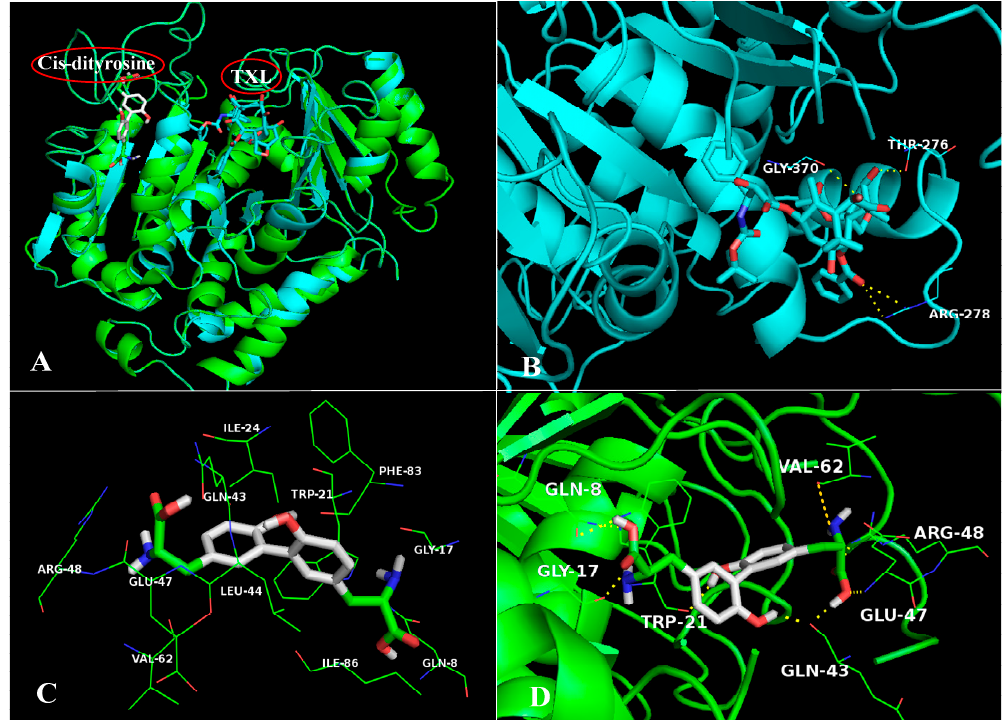
Figure 8. ( A ) Superposition between the crystallographic structures of the complex 1UTB/TXL with the resultant docking pose of 1UTB/CDT. Crystallographic structure and docking structure are represented in blue and green, respectively. ( B ) The enlargement for ligand TXL in the binding site of 1UTB, which is displayed as stick, hydrogen bonds are shown as dotted yellow lines, and the non-polar hydrogens were removed for clarity. ( C ) The active site amino acid residues around CDT. ( D ) The enlargement for ligand CDT in the binding site of 1UTB, which is displayed as stick, hydrogen bonds are shown as dotted yellow lines, and the non-polar hydrogens were removed for clarity.